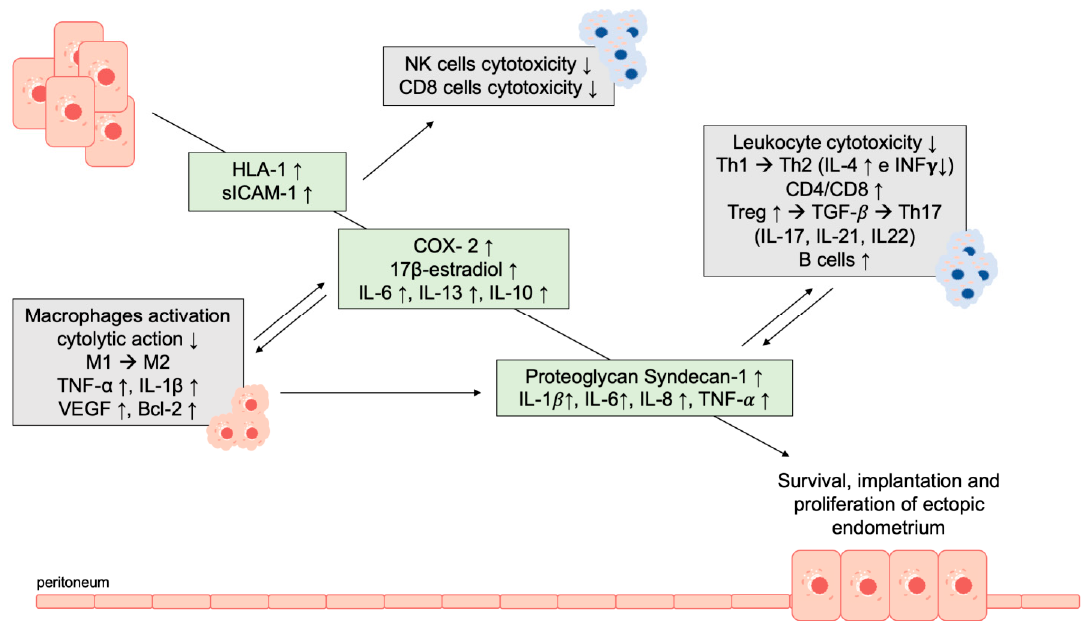
Figure 2. Immunoescaping mechanisms involved in the etiopathogenesis of endometriosis. Human leukocyte antigen class I (HLA-1); Intercellular adhesion molecule-1 (sICAM-1); Natural killer (NK); Cyclo-oxygenase type 2 (COX-2); Interleukins (IL); Tumor necrosis factor (TNF); Vascular endothelial growth factor (VEGF); Antiapoptotic protein B cell lymphoma 2 (Bcl-2); Interferon (INF); transforming growth factor- β (TGF- β ).